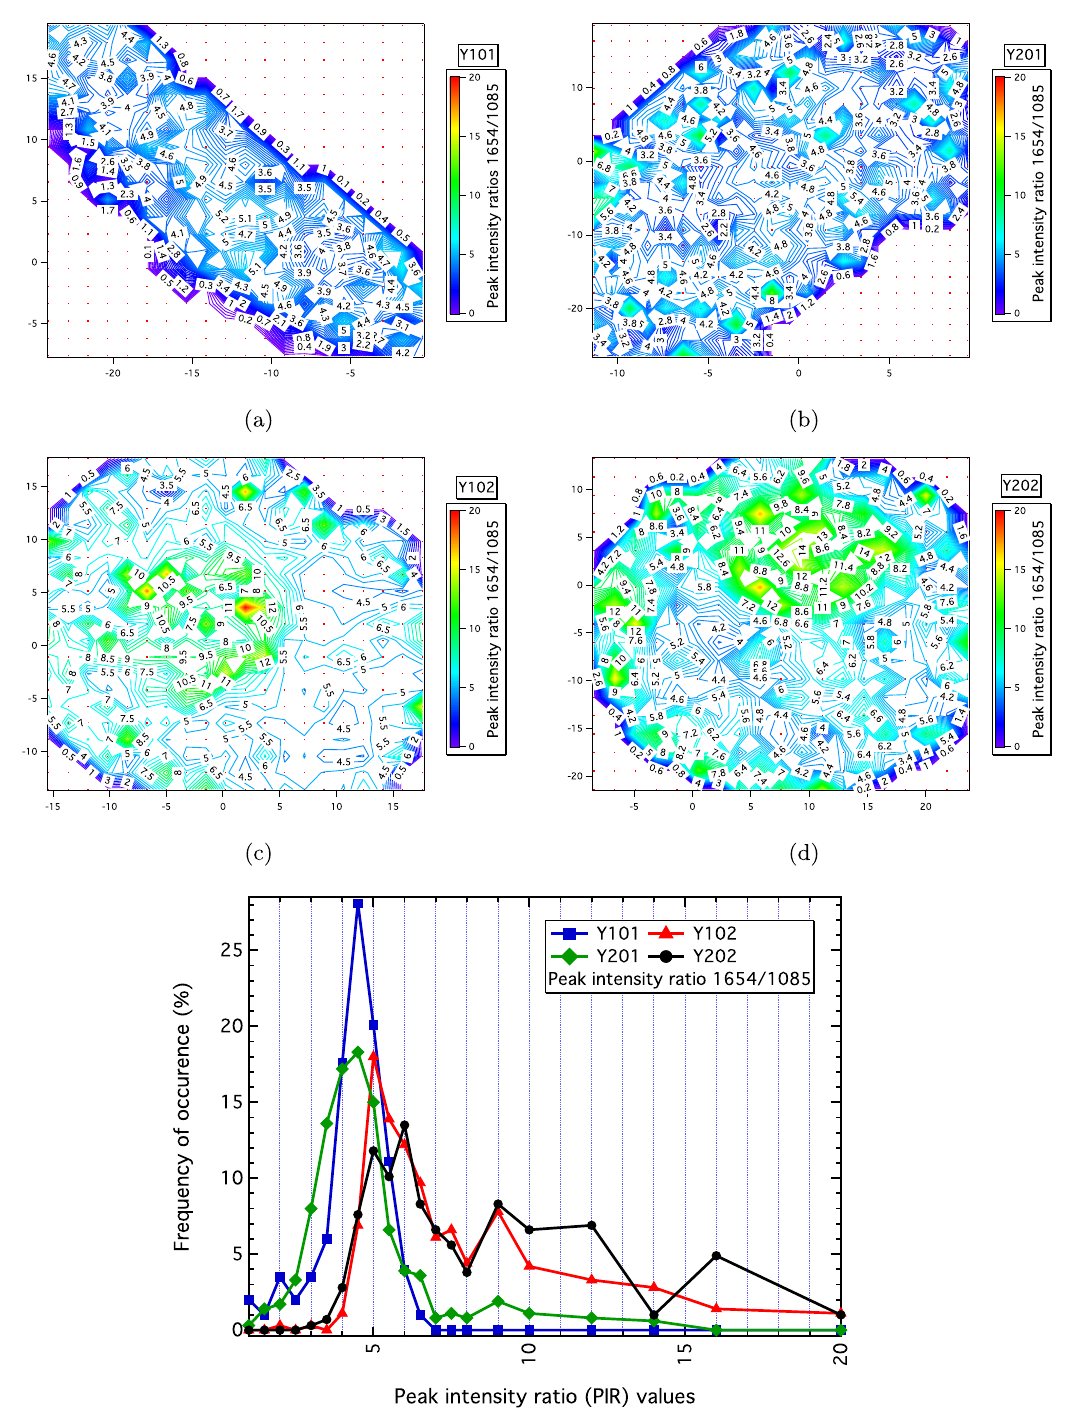
Figure 7. Spatially-resolved Raman maps showing the 1654/1085 PIR that separates the Y101/Y201 (differentiation competent) and Y102/Y202 (differentiation incompetent) hTERT MSC-lines. The differentiation-competent ( a ) Y101 and ( b ) Y201 cells have low, evenly distributed values for this marker, whereas the differentiation-incompetent ( c ) Y102 and ( d ) Y202 cells show concentrated “hot-spots” assumed to be within the cell nucleoli. ( e ) Percentage frequency of occurrence corresponding to the 1654/1085 PIR values measured over the spatially-resolved Raman maps showing discrimination of the Y101/Y201 and Y102/Y202 differentiation competencies. The values were normalised against the number of individual spectra (N) obtained for each cell nucleus [N(Y101) = 199; N(Y102) = 361; N(Y201) = 362 and N(Y202) = 288] and binned as per the points